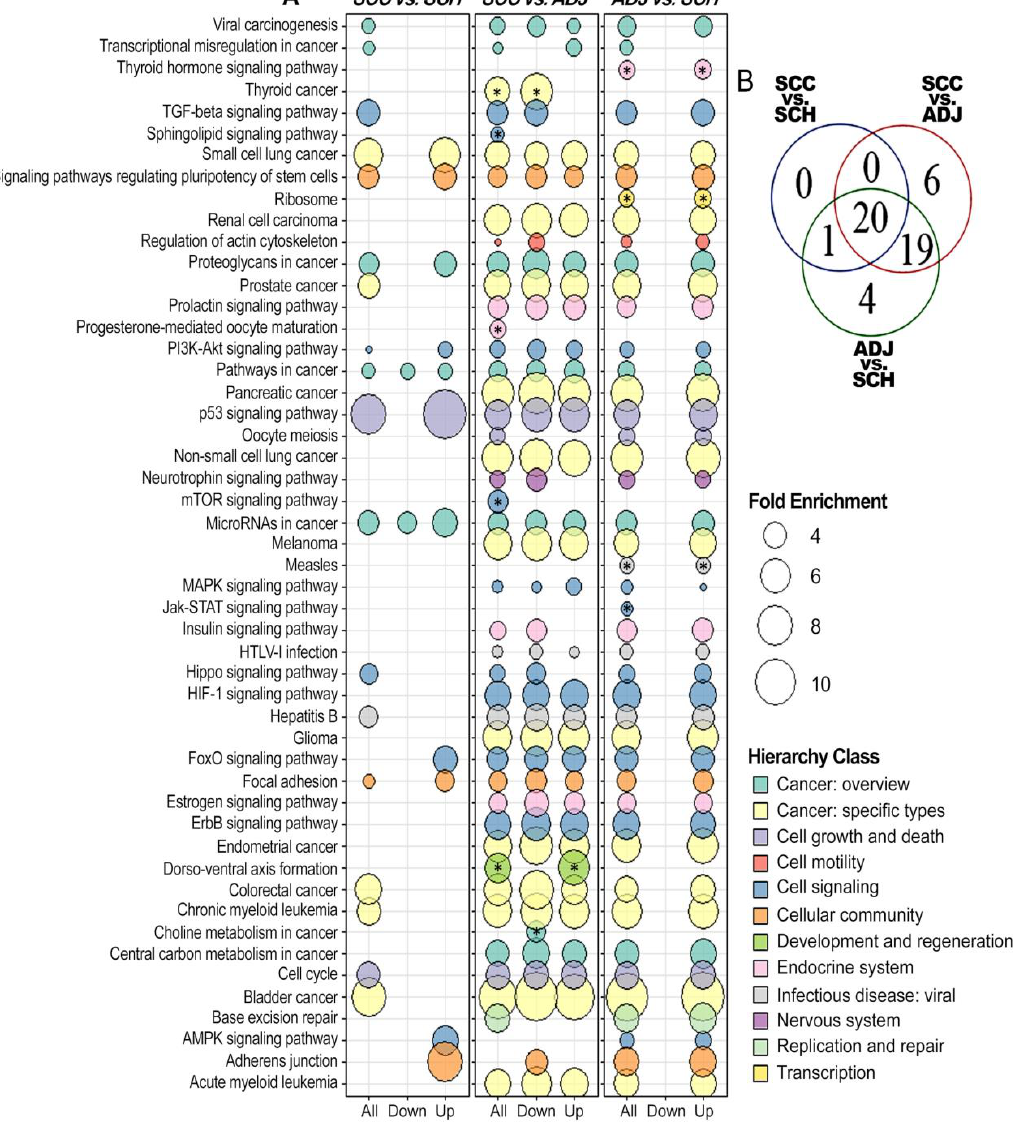
Figure 8. Gene set enrichment analysis of the DEmiRNAs. ( A ) The bubble chart shows significant pathways associated with the respective miRNA profile, according to the statistical model analyzed. This analysis was performed separately according to the profile of differentially expressed miRNAs. Fold enrichment was represented only for pathways that had Benjamin Hochberg’s adjusted p -value lower than 0.05. Each color represents a hierarchical class, according to the KEGG database. * = The KEGG was associated with one statistical comparison. ( B ) The Venn diagram shows all possible logical relations between the pathways obtained during gene enrichment analysis of statistical model